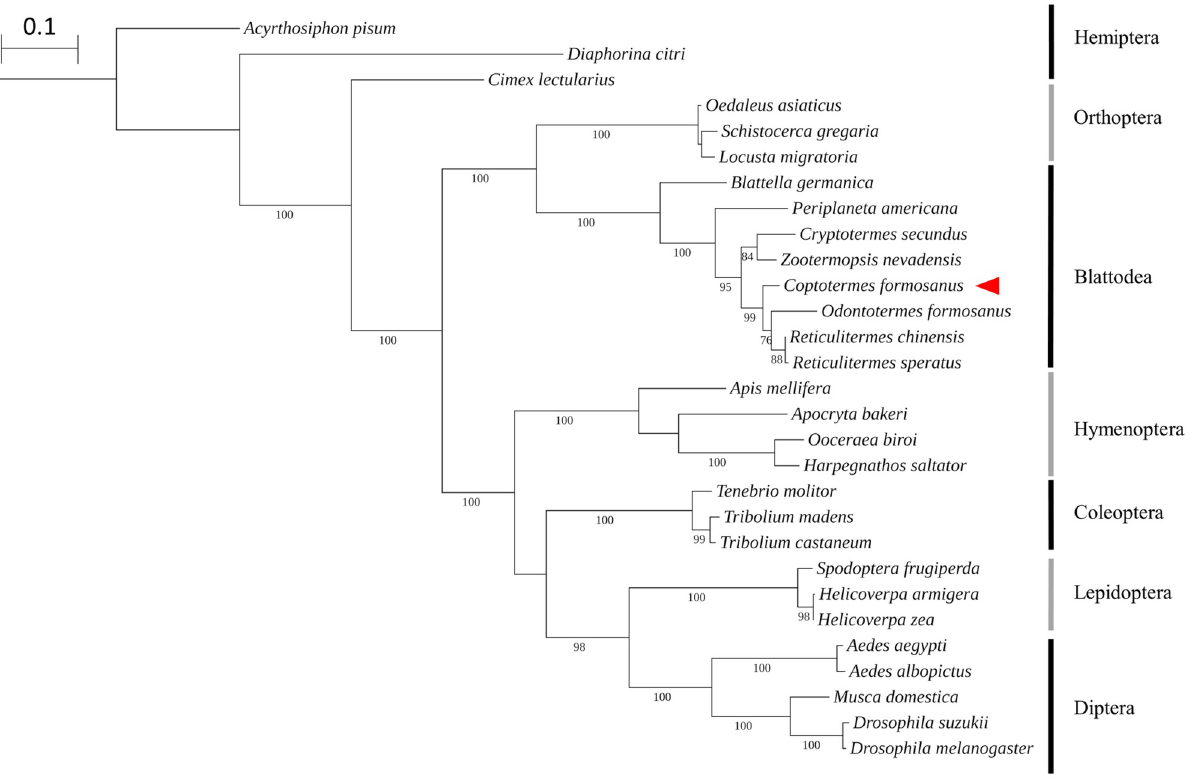
Fig 3. Phylogenetic relationships of Orco across different insect taxa. The maximum likelihood tree was constructed based on the amino acid sequences of Orco in different insect species. Species of focus in this study is indicated with a red arrow. Numbers in each branch correspond to the bootstrap values. The scale bar represents number of substitutions per